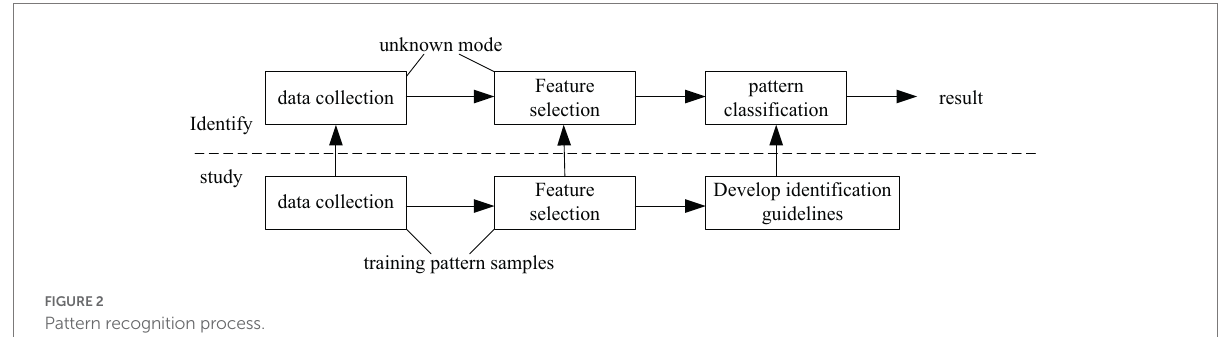
FIGURE 1 Artificial intelligence application areas.